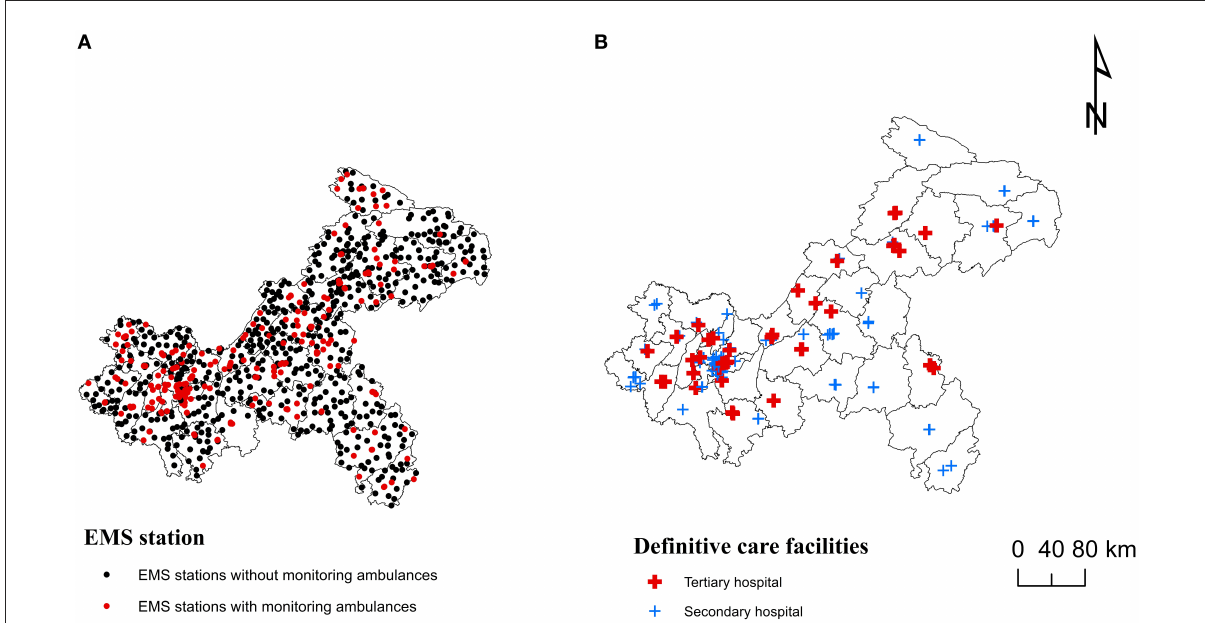
TABLE 3 Distribution of the shortest ravel time to get ambulance services. Shortest travel time (min)